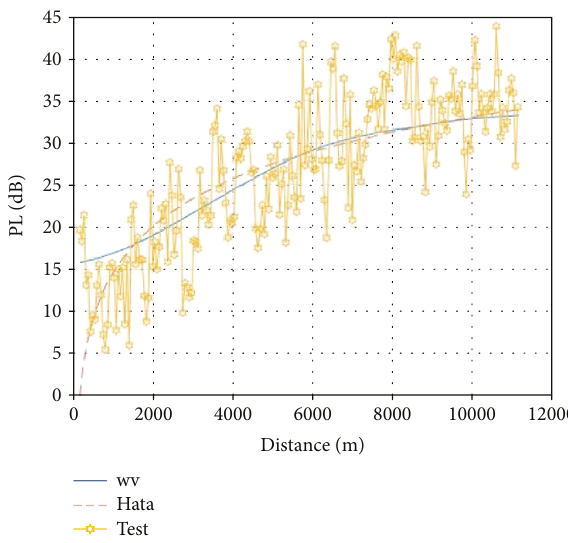
Figure 3: Propagation loss versus distance. wv: wavelet method using db7 and level 11; Hata: optimized Hata model; test: measurement